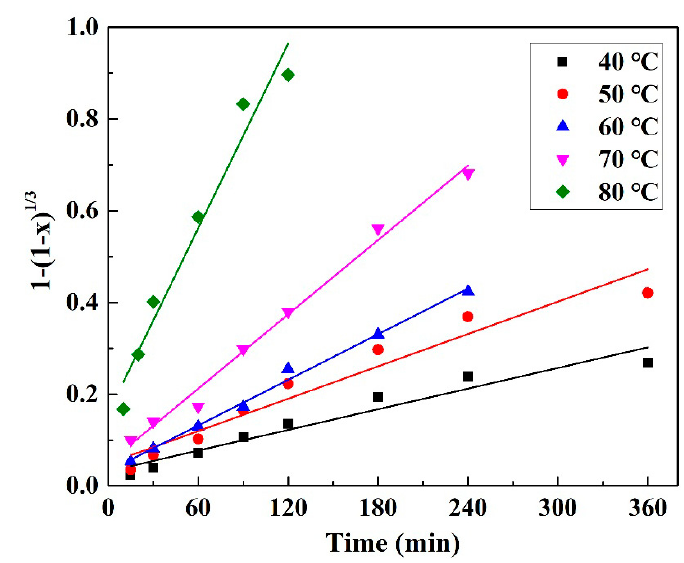
Figure 7. Plots of the shrinking-core model for chemical reaction control for Pd leaching. Table 3. The kinetics parameters of chemical reaction control model for Pd leaching.